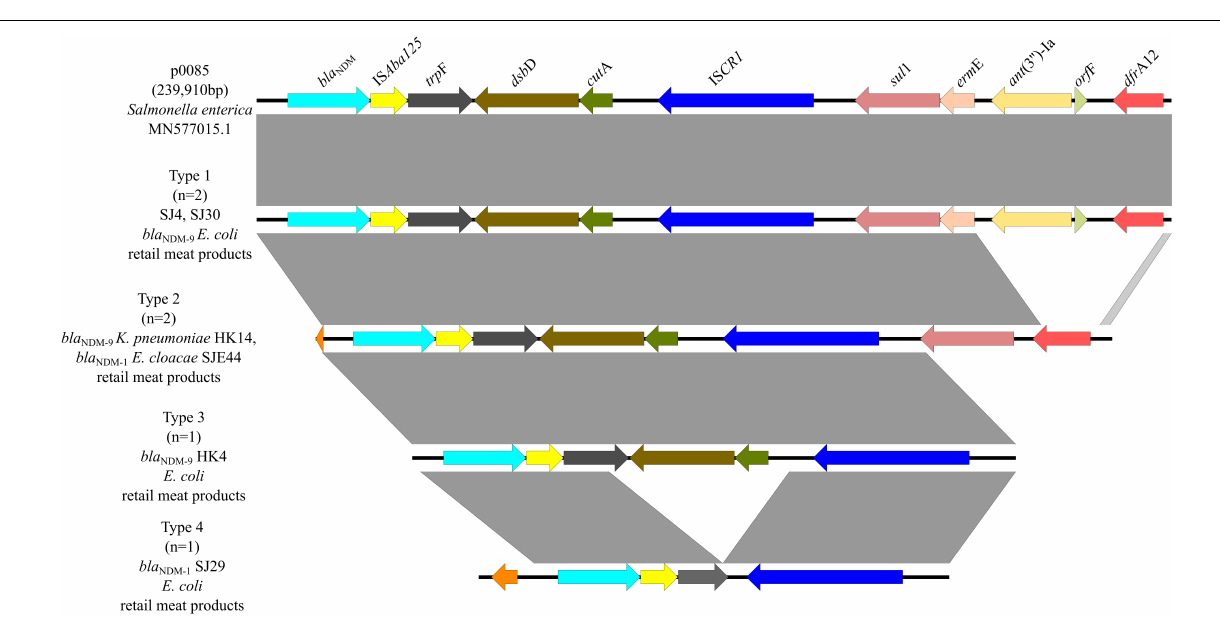
genes were identified, including bla NDM − 1 , bla NDM − 5 , bla NDM − 7